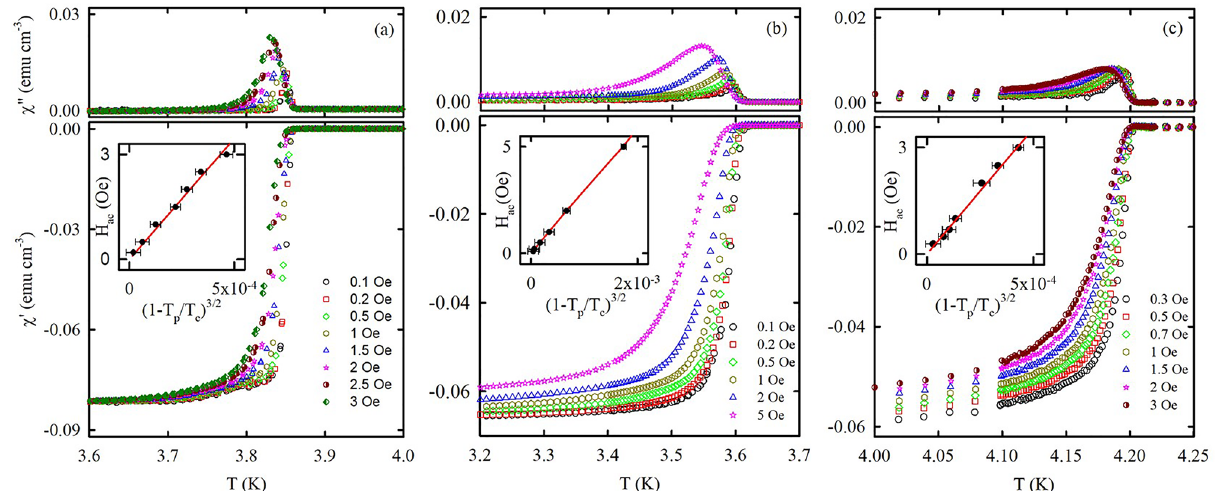
Figure 4. Temperature dependences of ac susceptibility at zero field for ( a ) O-Sn, ( b ) O-In, and ( c ) O-Hg with different ac driving amplitudes indicated in the lower panels. The ac driving frequency is 500 Hz. The upper and lower panels show the imaginary and real parts of ac susceptibility, respectively. The insets show the dependences of the ac field amplitudes on (1 − T p / T c ) 3/2 . The solid lines are linear fits.